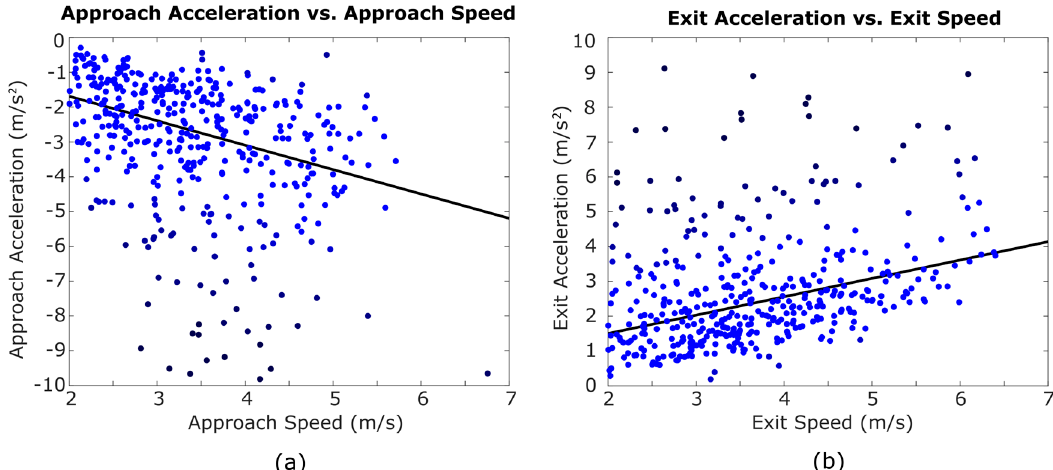
Figure 6. A linear regression model was applied to each data set to generate trend lines. Both approach ( a ) and exit ( b ) accelerations increased in magnitude with higher approach and exit speeds. Iterative weighted robust fitting was used to reduce the influence of outliers. Outliers were shaded darker than data closer to the trend line. 13 acceleration and 4 speed outliers are outside this view.